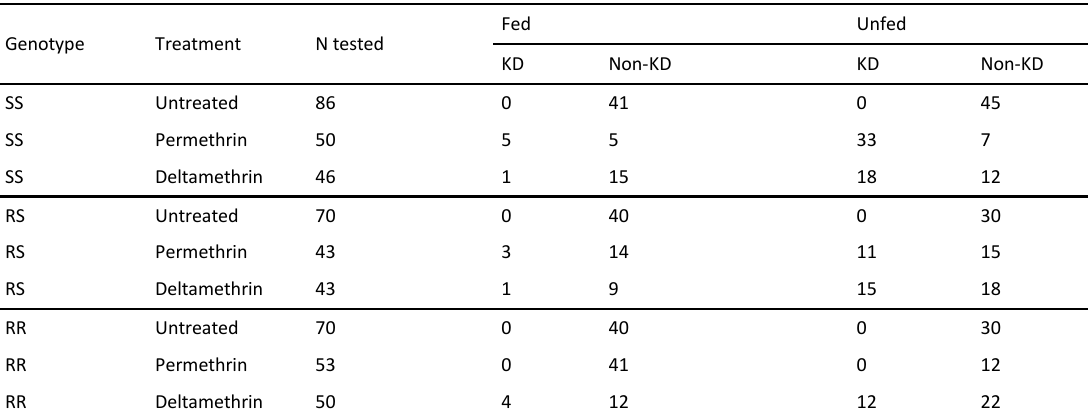
Table 1. Numbers of mosquitoes released per genotype and